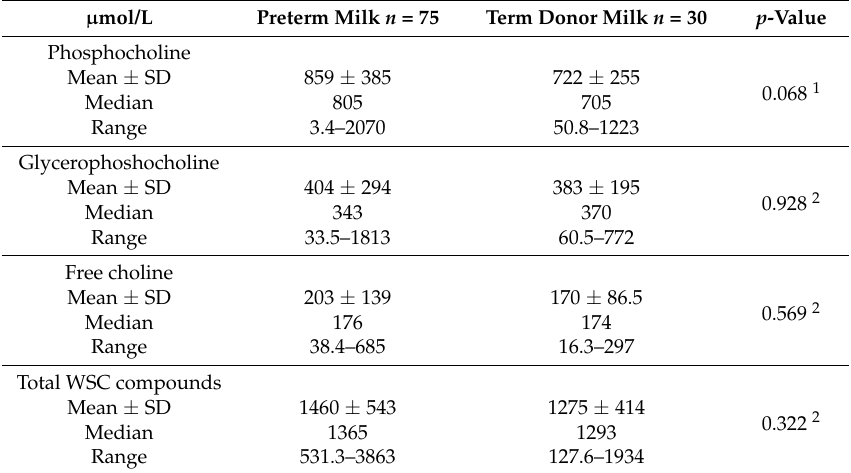
Table 1. Concentrations of water-soluble choline compounds in human preterm and term donor milk